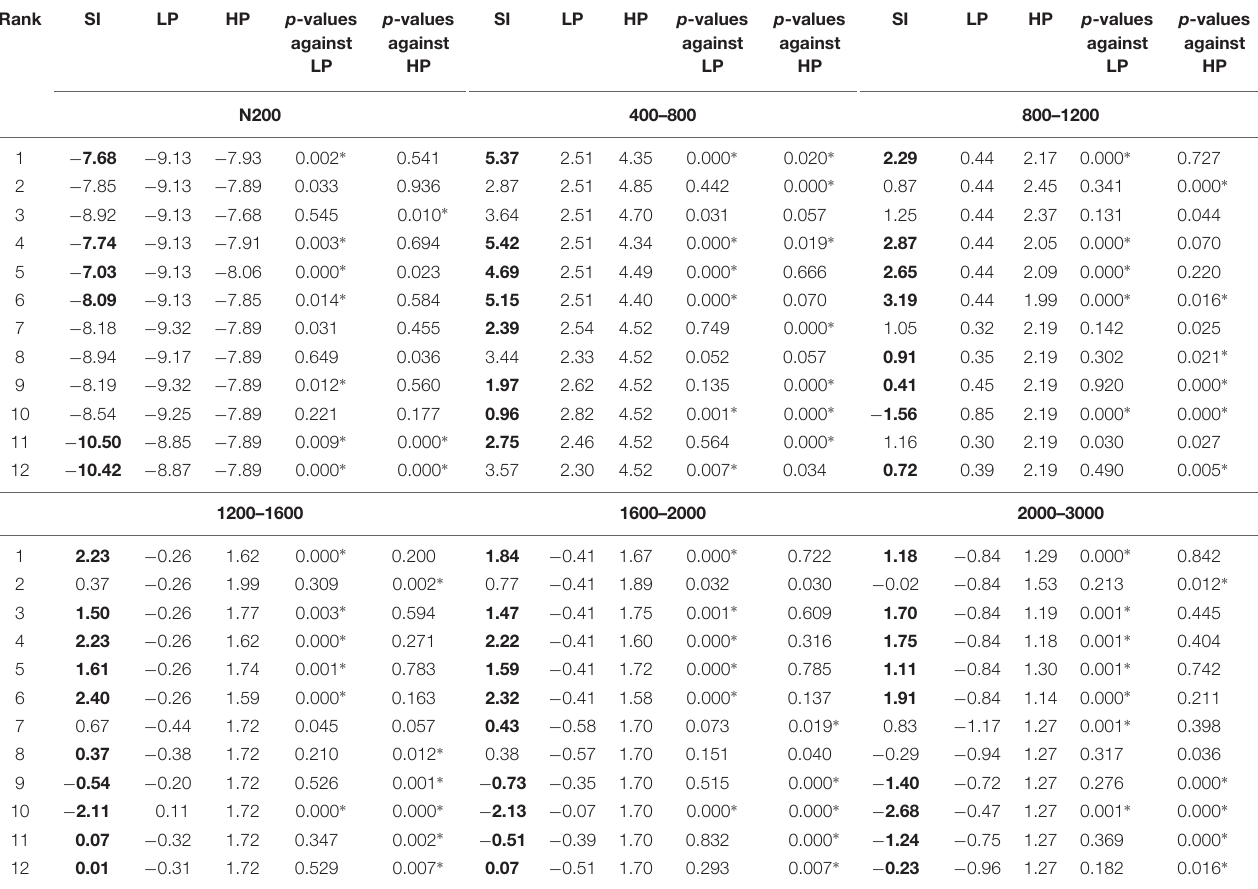
TABLE 1 | Single-item ERPs compared to the averaged ERPs of highly preferred (HP) and less preferred (LP)